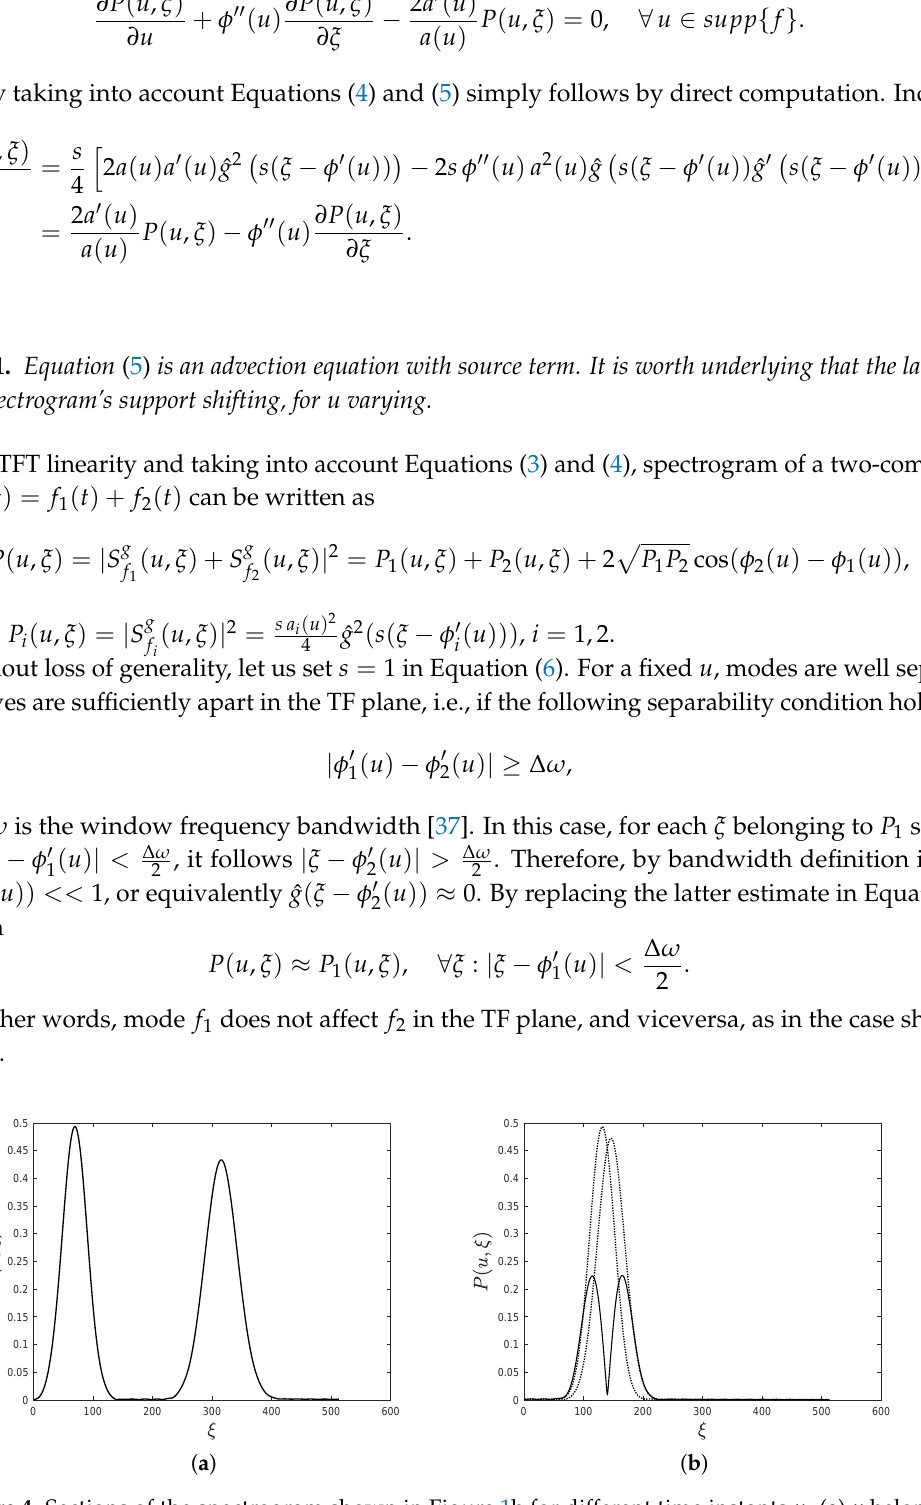
Figure 4. Sections of the spectrogram shown in Figure 1b for different time instants u . ( a ) u belongs to the separability region and then two well separated profiles are observed. ( b ) u belongs to the non-separability region. The profiles of the spectrogram of the individual components (dotted line) have overlapped supports. As a result, spectrogram (solid line) does not match the single